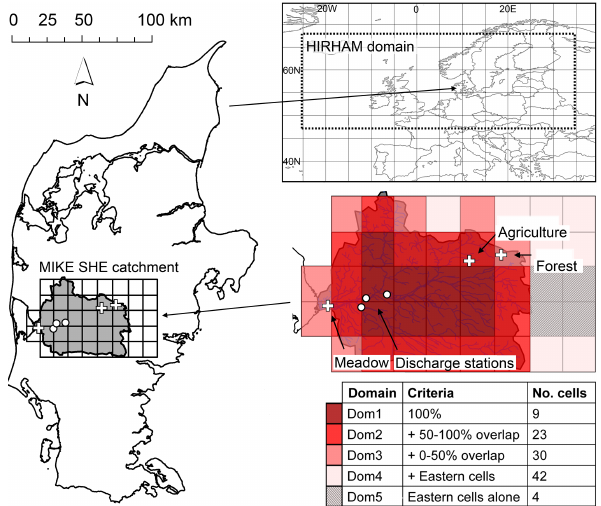
Figure 1. Location of HIRHAM regional climate domain within Europe, MIKE SHE catchment within Denmark, three point mea- surement sites and location of five evaluation